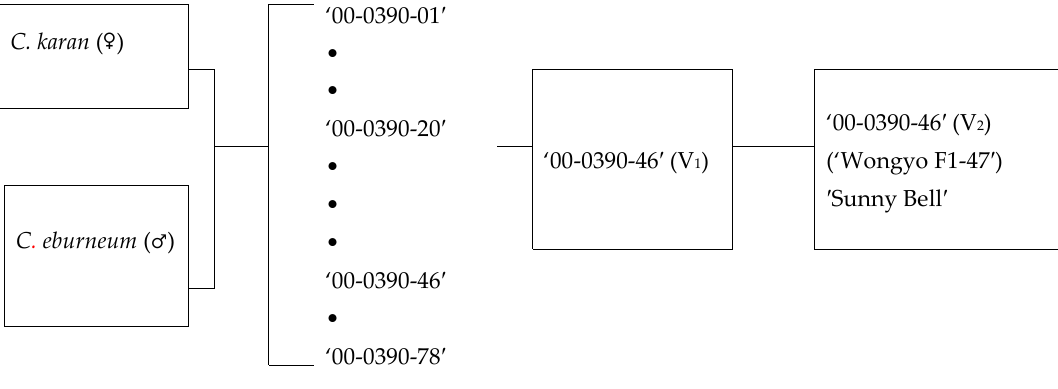
plants in each Figure 2. Pedigree diagram of the new hybrid, Cymbidium “Sunny Bell”. “•”indicates the number of plants in each lane.